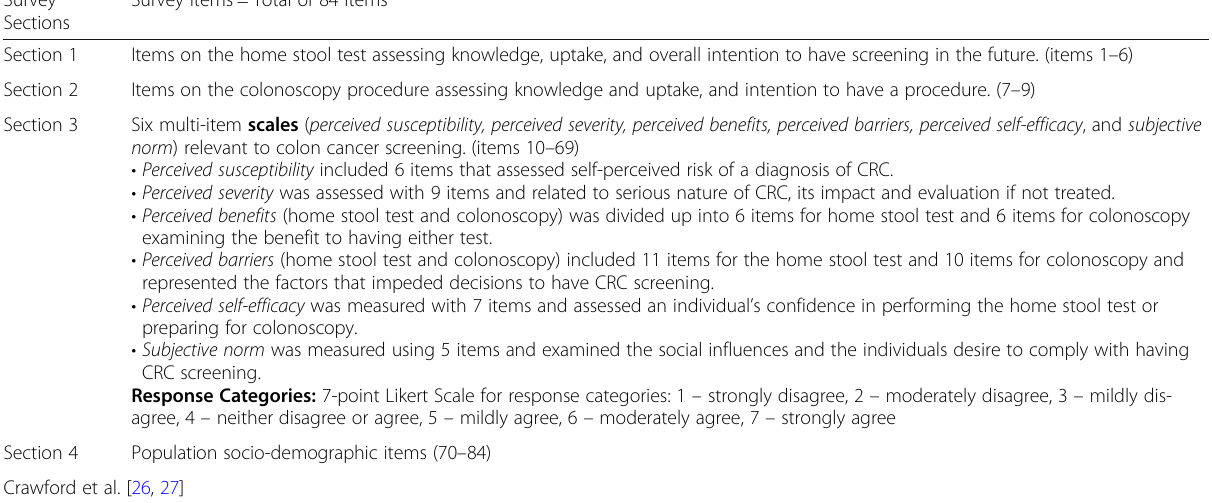
Table 1 Colon Cancer Screening Behaviours Survey Survey